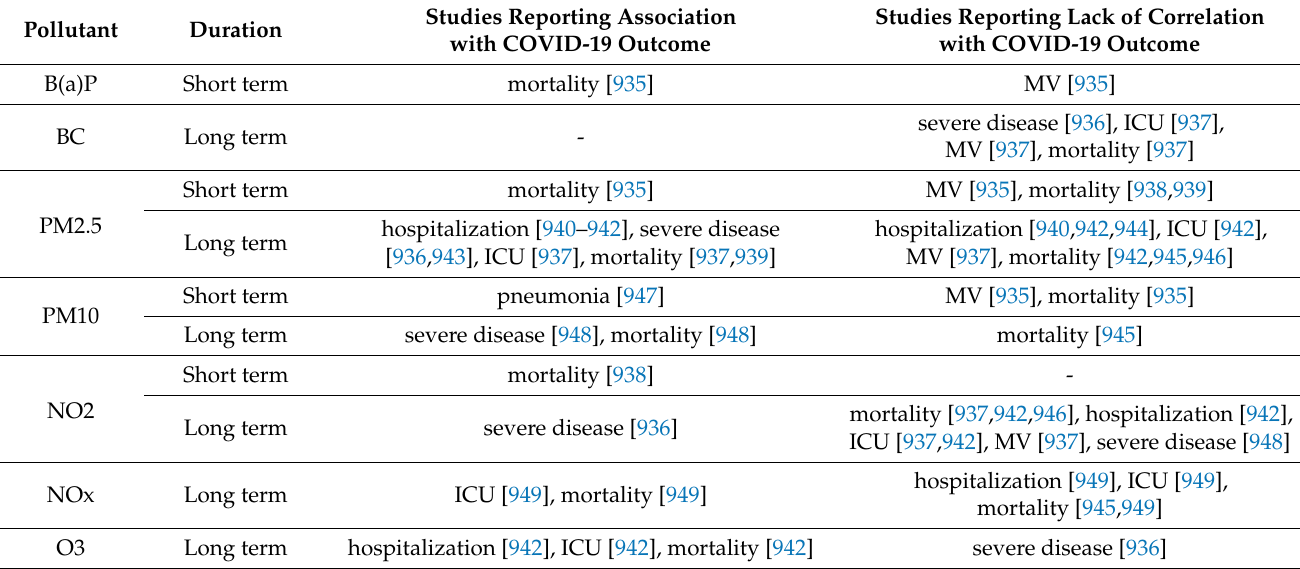
Table 8. Individual-level studies investigating the association between air pollutant exposure and risk of severe clinical outcomes with